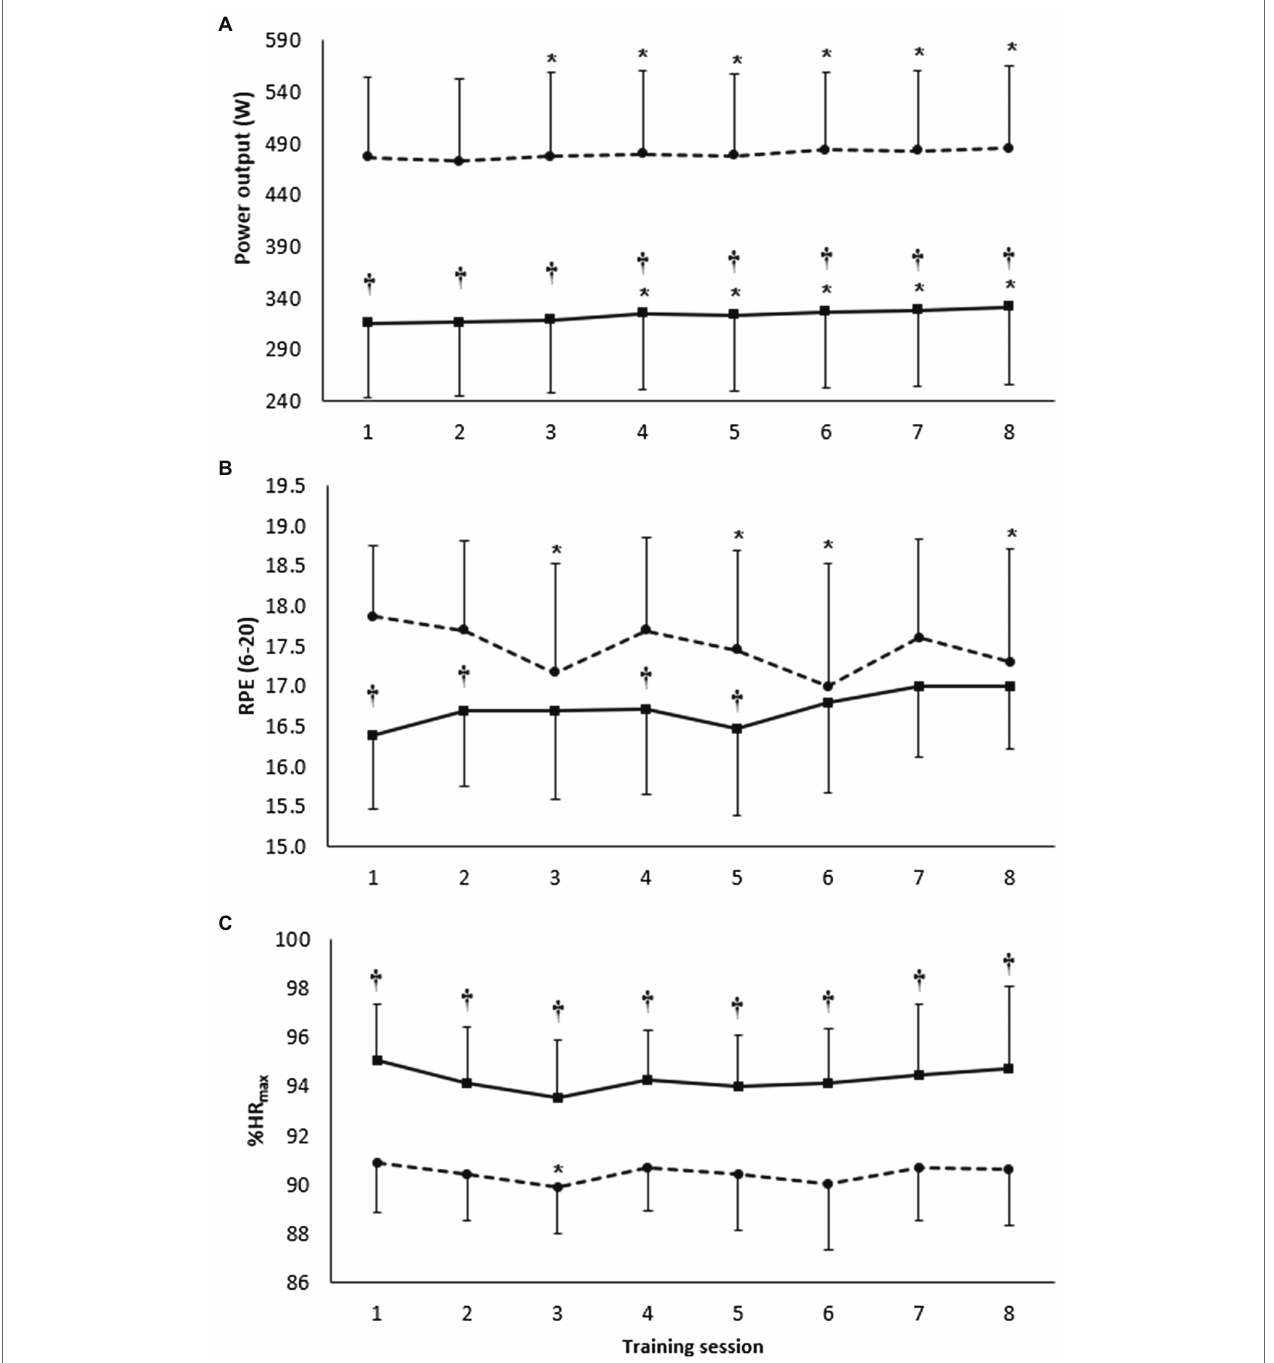
cross-over design with 4 weeks of HIIT and control training balanced across two matched groups. Akca and Aras (2015) implemented a 4-week block of HIIT. Ní Chéilleachair et